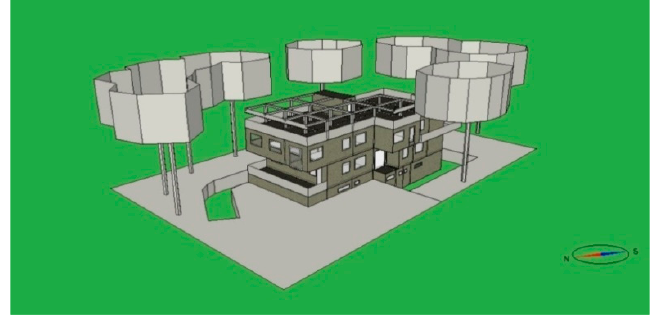
Figure 5. First guess model in IDA-ICE’s 3D